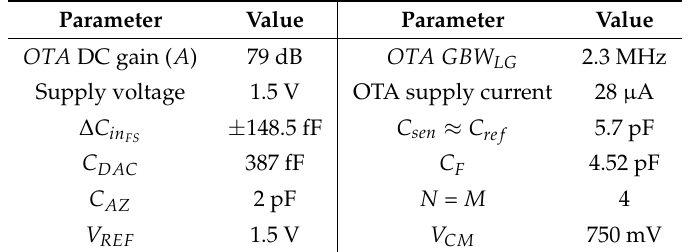
Table 2. CDC circuit design parameters for real pressure sensor MEMS